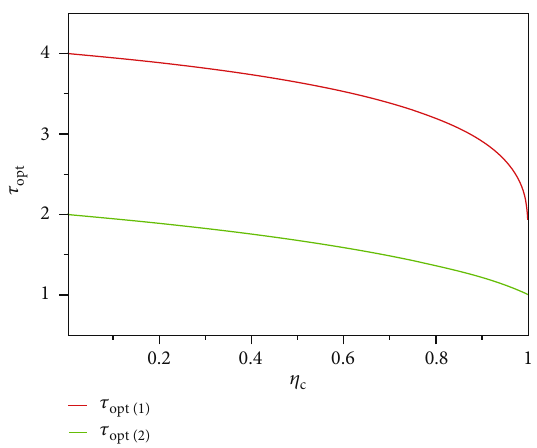
Figure 5: The numerical values of the ratio of optimized e ffi ciency for the two cases of optimization criteria to the e ffi ciency at maximum power versus the Carnot e ffi ciency.